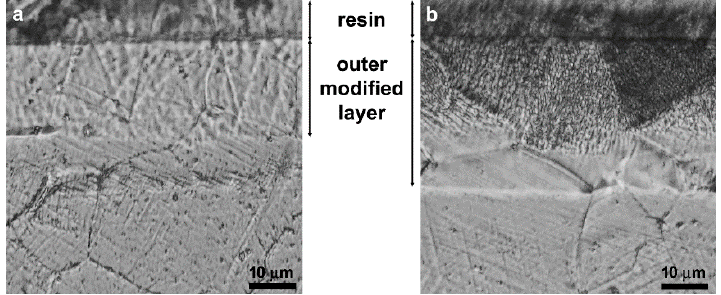
Figure 6. Micrographs of samples nitrided with 50 vol.% N 2 + 50 vol.% H 2 , for 3 h, at 360 ( a ) and 380 ( b ) °C. (Tapered section: the markers refer to the length in the tapered section; etchant: glyceregia).